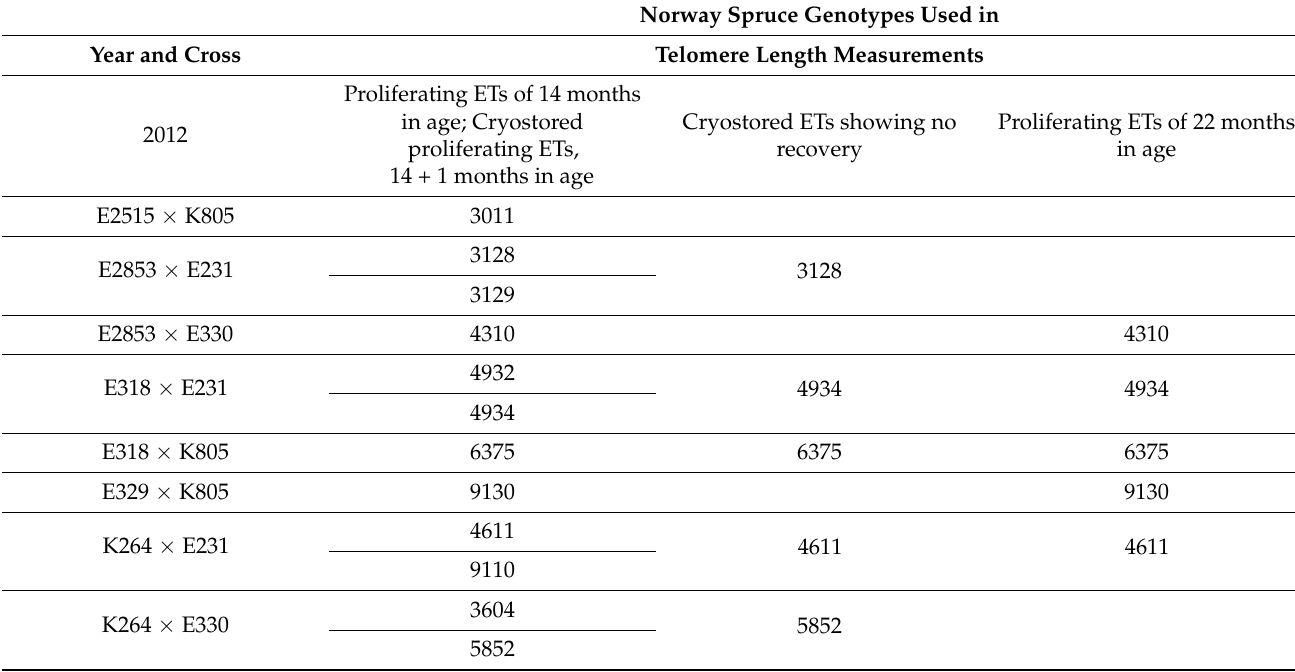
Table A3. Norway spruce materials used in somatic embryogenesis and telomere length studies: Controlled crosses from which the embryogenic tissues (ETs) were derived, and genotypes used to examine embryo production capacity and length of telomeric repeats in ETs of varying age, prior to and following